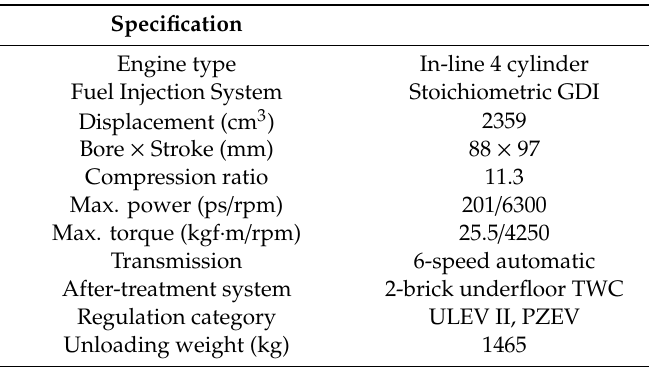
Table 1. Specifications of the test vehicle.